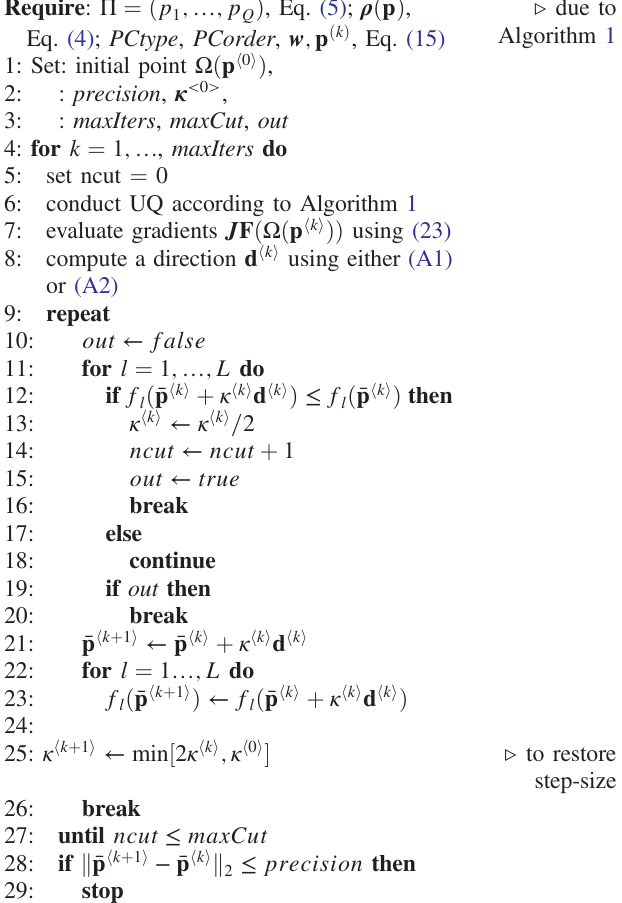
TABLE II. Results for the 1D constrained optimization — parameter domain.